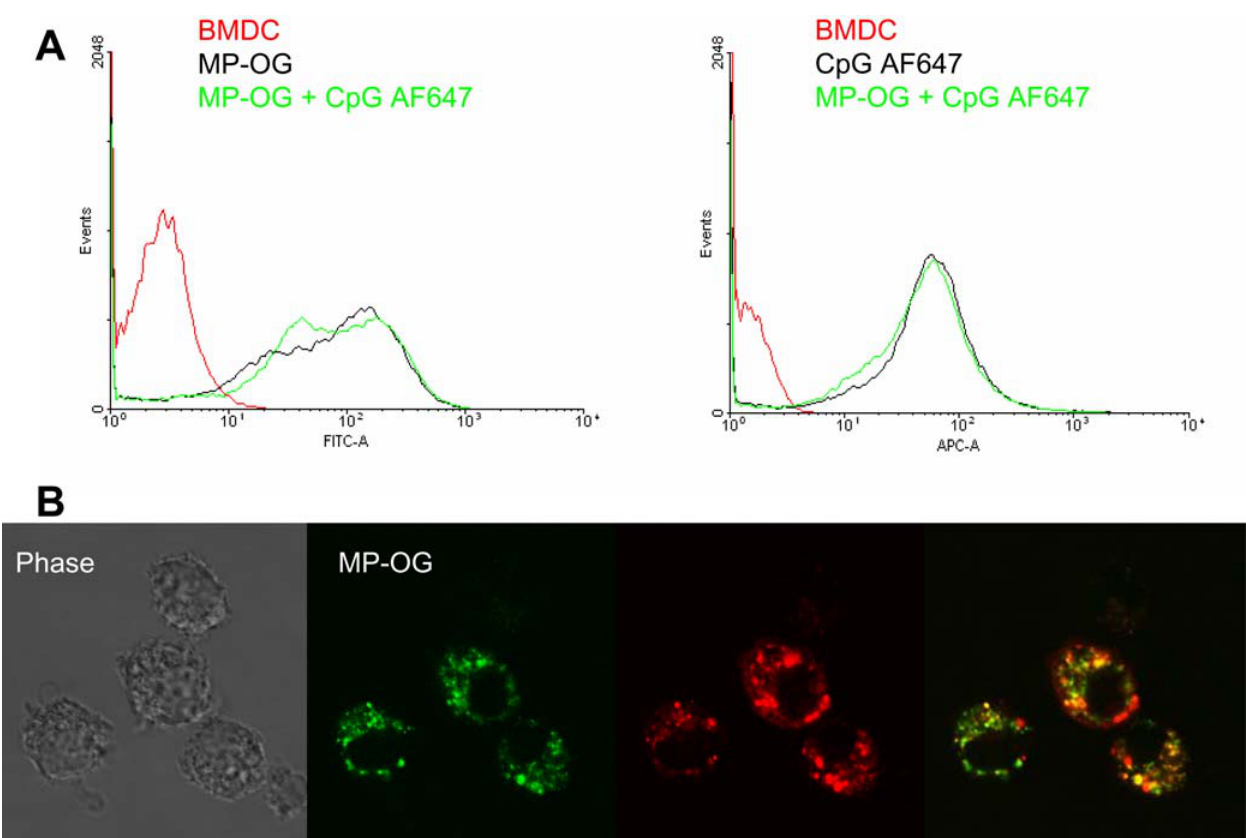
Figure 5. MP and CpG are taken up independently but can colocalize in intracellular compartments. (A) MP-OG (10 m g/ml) and 1 m M CpG ODN 1826-AF647 were incubated with cDCs for 15 minutes and analyzed by flow cytometry. Plots are representative of two independent experiments. The plot on the left demonstrates no effect of CpG AF647 on cellular uptake of MP-OG. The second plot demonstrates no effect of MP- OG on cellular uptake of CpG AF647. (B) cDCs were incubated with 10 m g/ml MP-OG (green) and 1 m M CpG ODN 1826-AF647 (red) for 20 minutes and then analyzed by confocal microscopy. Yellow pseudocolor represents areas of colocalization of MP and CpG within DCs.